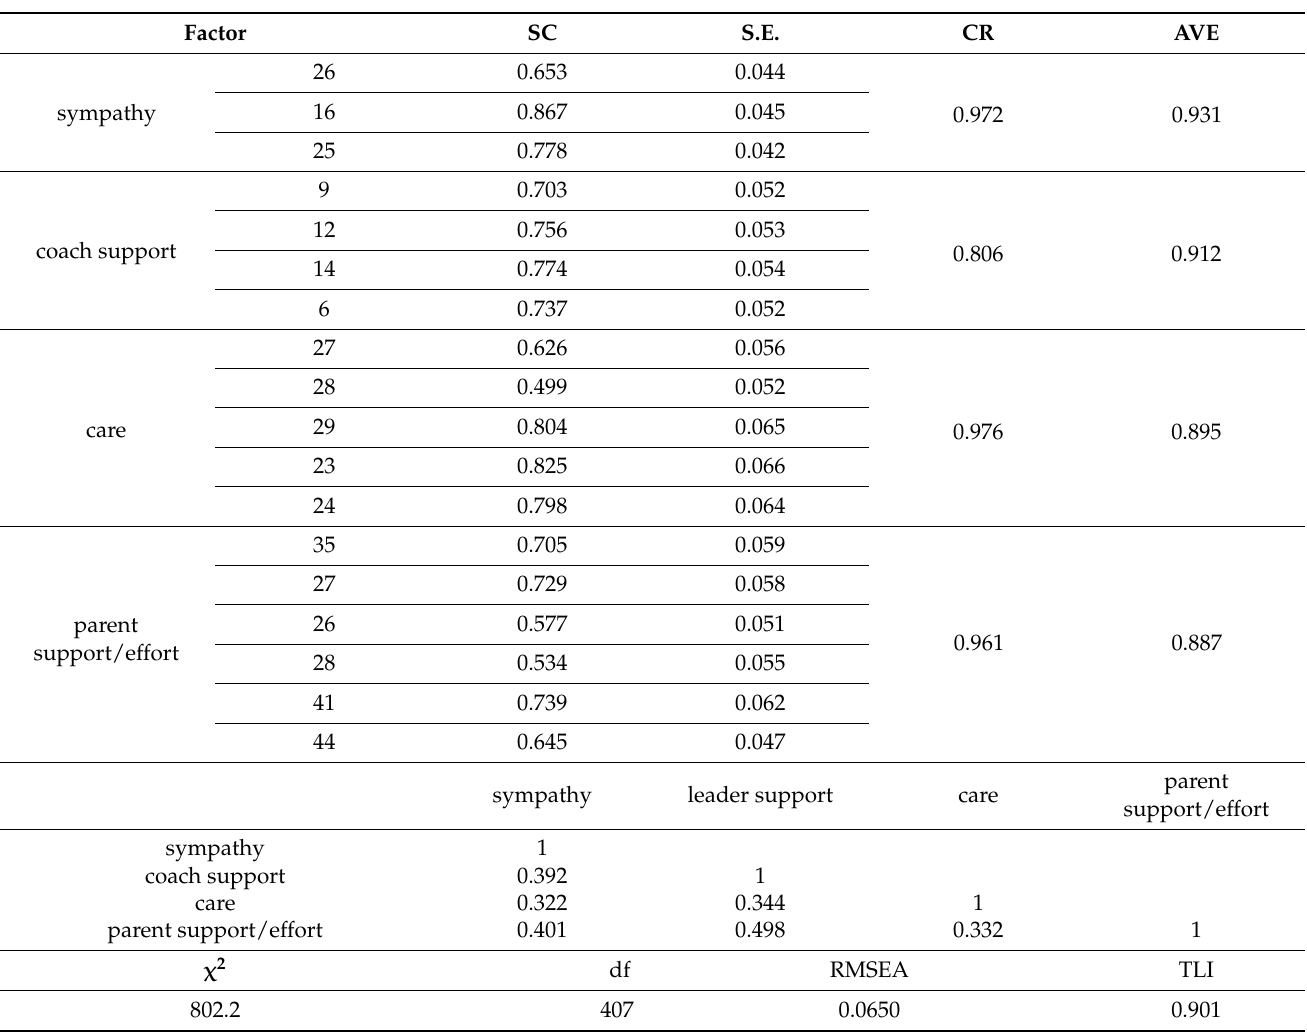
Table 10. Results of ML